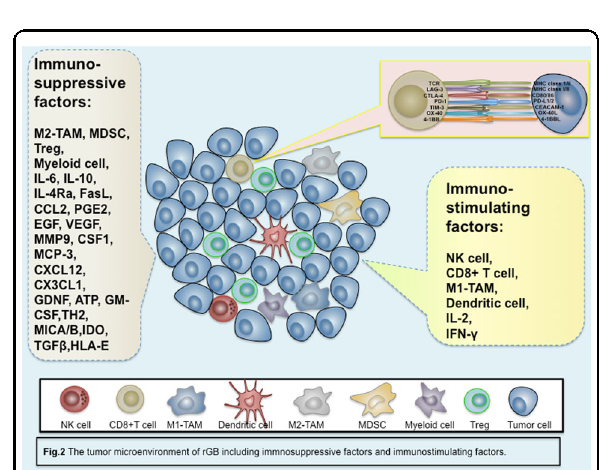
Fig. 2 The tumor microenvironment of rGB. The immunosuppressive microenvironment of rGB is composed of a variety of immunosuppressive cells and cytokines which outweigh the role of immunostimulatory